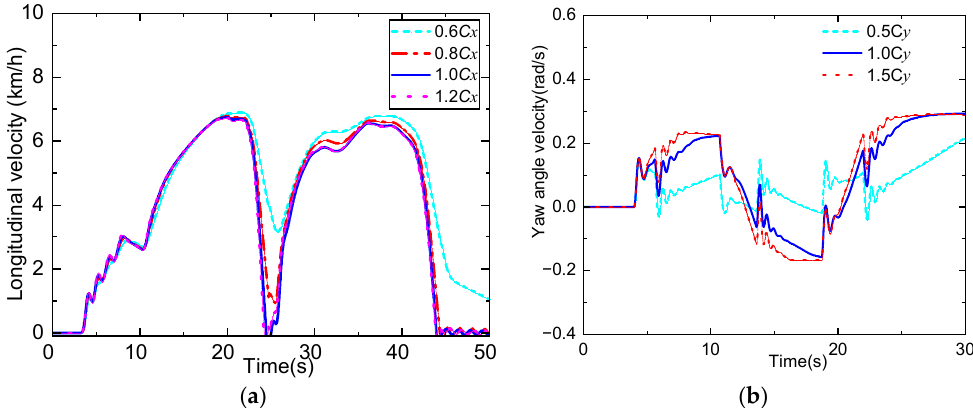
Figure 14. Model-based analysis results: ( a ) e ff ects of longitudinal sti ff ness of tires; ( b ) e ff ects of lateral sti ff ness of tires.